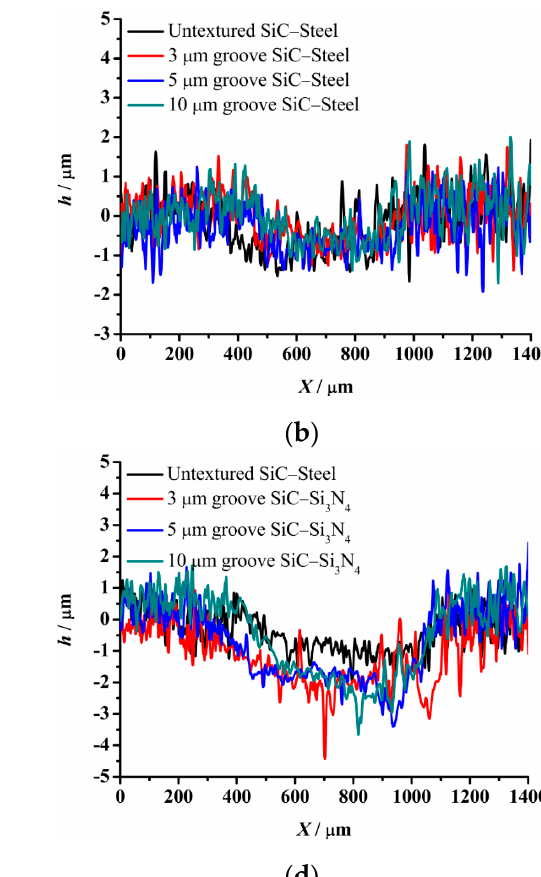
Figure 17. Wear performance of groove-textured SiC under water-lubricated conditions with a load of 75 N (×10): ( a ) 3 μ m groove-textured SiC-steel ball, ( b ) 3 μ m groove-textured SiC–Si 3 N 4 ball, ( c ) 5 μ m groove-textured SiC–steel ball, ( d ) 5 μ m